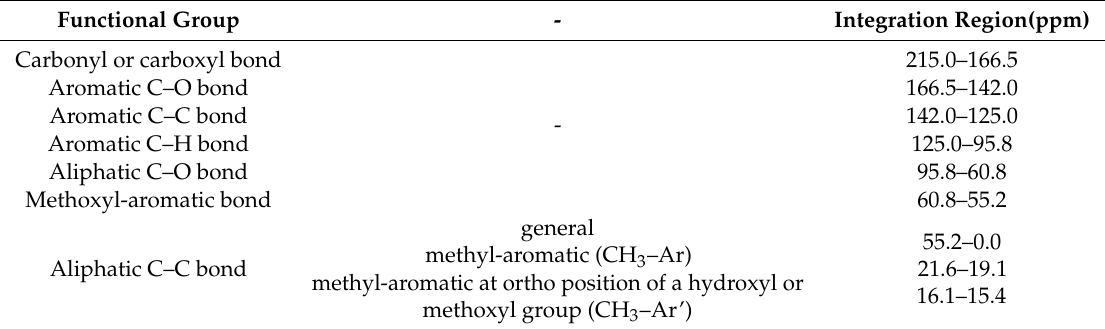
Table 2. The 13 C nuclear magnetic resonance (NMR) chemical shift assignment ranges and